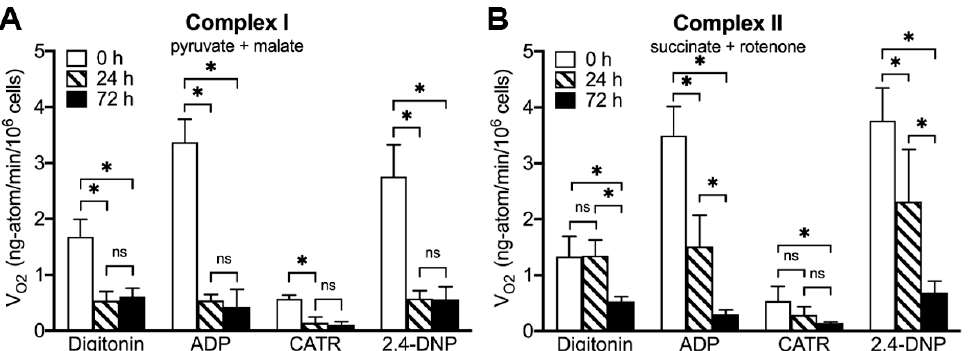
Figure 6. ONC201-induced suppression of mitochondrial respiratory chain activity. ( A ), Rate of oxygen consumption of BT474 cells, oxidizing Complex I substrates. ( B ), Rate of oxygen consumption of BT474 cells, oxidizing Complex II substrates. Open bars demonstrate respiration of untreated cells (0 h exposure to drug); Striped bars reflect the respiration of short-term treated cells (24 h); and Filled bars show the effect of ONC201 on the activity of respiratory complexes after 72 h of exposure. Oxygen consumption rate by intracellular mitochondria was assessed following permeabilization of plasma membrane with 0.005% digitonin and subsequent additions of 200 µM ADP, 1 µM Carboxyatractyloside (CATR) and 25 µM 2,4-DNP. Shown are mean ± SD from at least three independent experiments. Statistical significance was estimated using one-way ANOVA with post-hoc Bonferroni test, * p < 0.05, “ns”, non-significant.